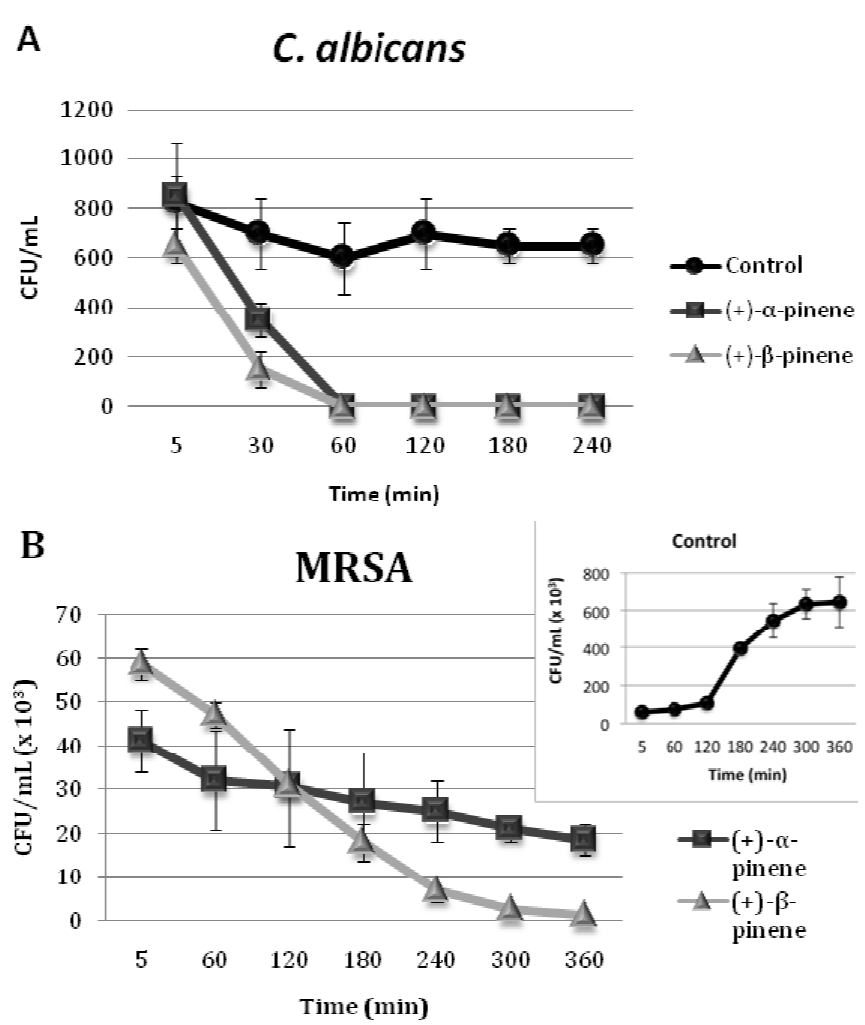
Figure 2. Time-kill curves of C. albicans ( A ) and MRSA ( B ) treated with (+)-  -pinene and (+)- β